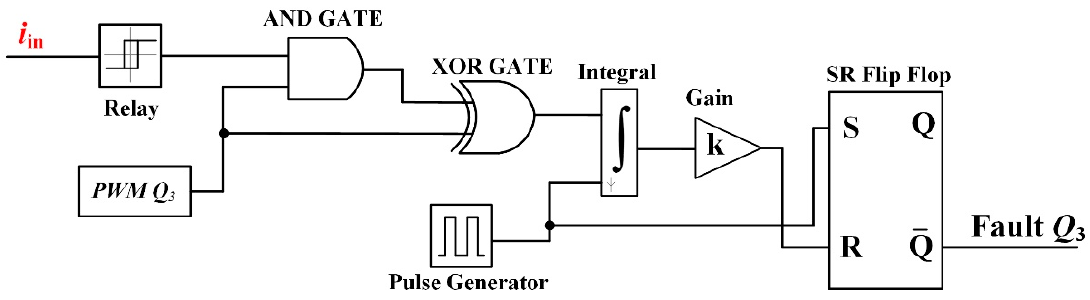
Figure 5. A schematic diagram of the developed fault diagnosis method of phase 3.